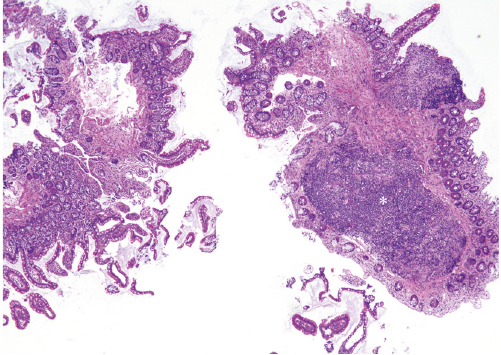
Figure 3: A periodic acid-Schiff (PAS, 200x) special stain displays the PAS-positivity of the